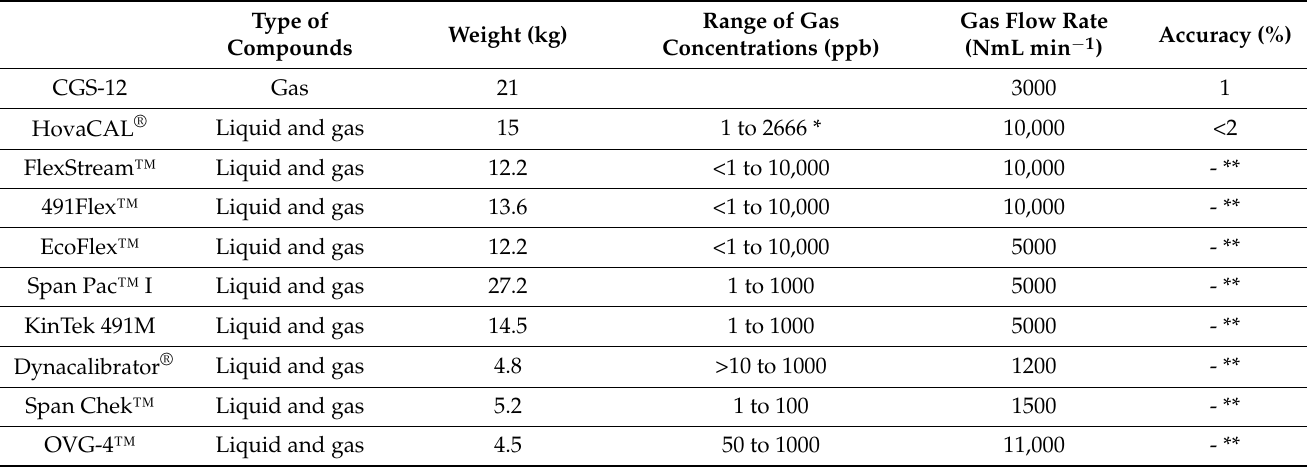
Table 1. Limiting characteristics of the different mixture generating devices on the